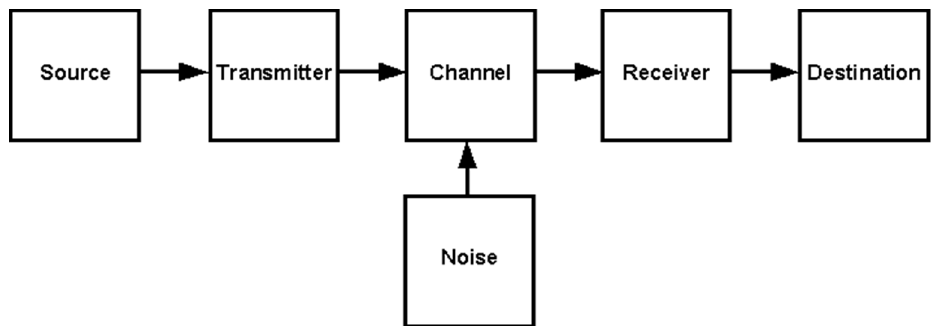
Figure 4. Basic block diagram of Shannon information theory. Information moves from the source to the final destination with the overall goal to be minimizing both the noise and total amount of required